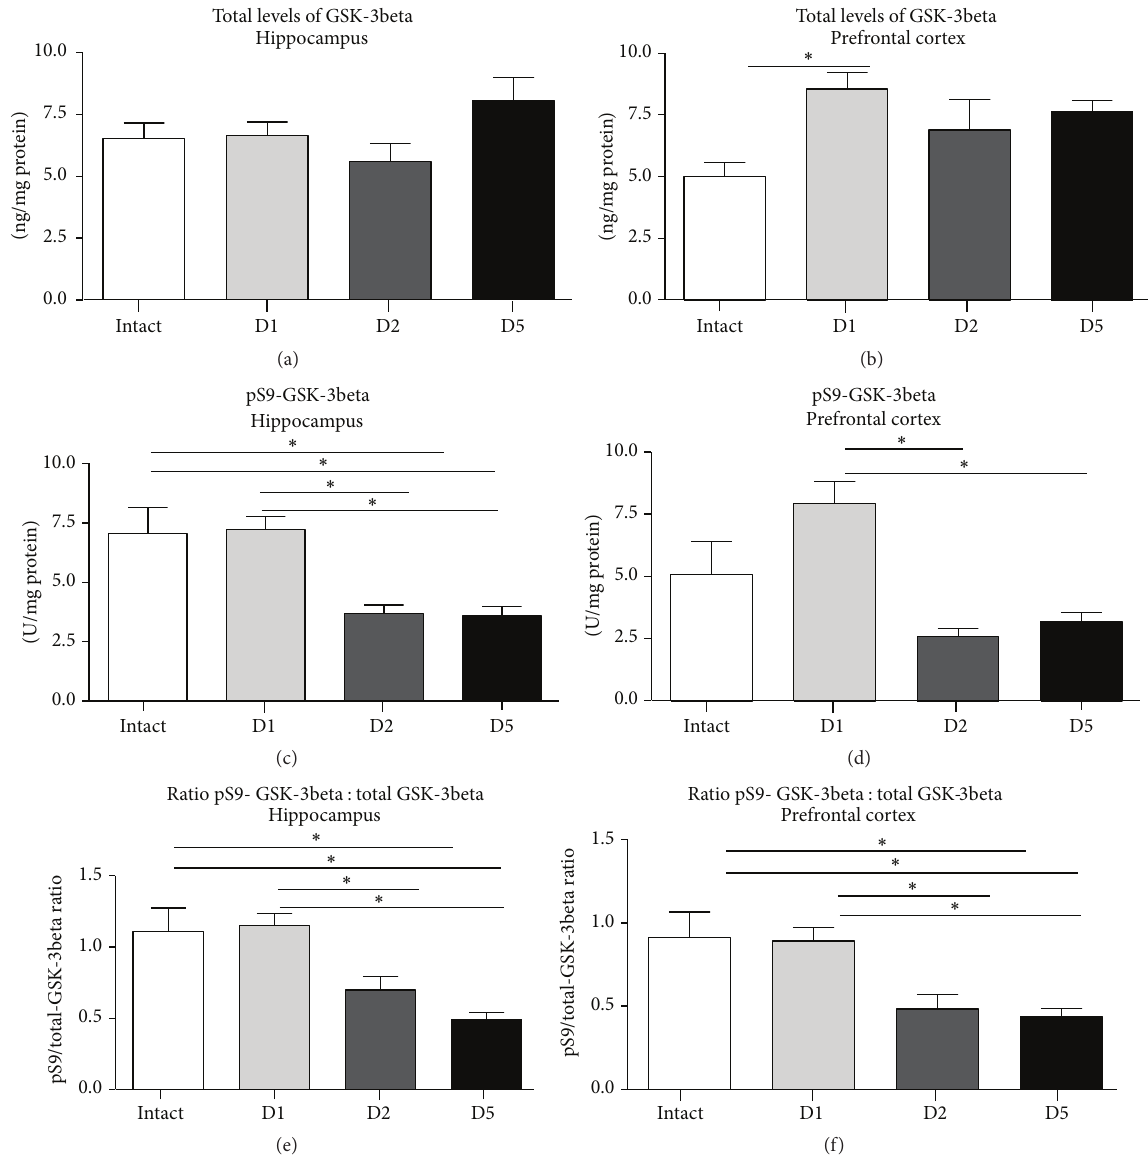
Figure 4: Brain levels of total and phosphorylated forms of GSK-3beta in the modified swim test. (a) In comparison to intact controls ( 𝑛 = 7 ), hippocampal level of total GSK-3beta was not significantly changed on Day 1 ( 𝑛 = 14 ), nor on Day 2 ( 𝑛 = 10 ) or on Day 5 ( 𝑛 = 12 ) of swim test. (b) In comparison to intact group, total level of GSK-3beta in the prefrontal cortex was significantly increased on Day 1 of swim test but not on Day 2 and Day 5; group sizes as indicated above. (c) In comparison to intact animals, hippocampal level of phosphorylated form of GSK-3beta was significantly decreased on Day 2 and Day 5, but not on Day 1 of the test; group sizes as indicated above. (d) In comparison to intact mice, the levels of pS9- GSK-3beta in prefrontal cortex were not altered on Day 2 and Day 5 of swim test; group sizes as indicated above. In comparison to intact controls, ratio of total/pS9 GSK-3beta (e) in the hippocampus and (f) in the prefrontal cortex was significantly decreased on Day 2 and Day 5, but not on Day 1; group sizes as indicated above. ∗ 𝑝 < 0.05 , ANOVA and Tukey’s multiple comparisons test; see the text. D1: Day 1; D2: Day 2; D5: Day 5. Data are mean ±